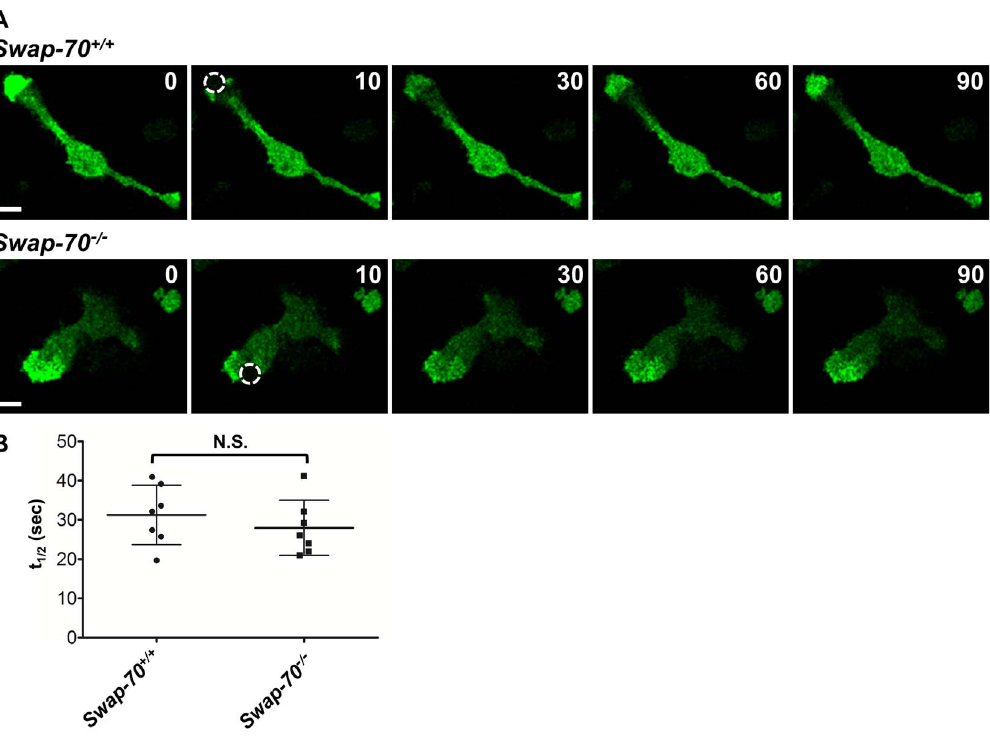
Figure 3. Podosome turnover is not affected by SWAP-70 deficiency in DCs. ( A ) FRAP analysis. Actin-GFP transduced Swap-70 + / + and Swap- 70 –/– DCs were seeded on poly-L-lysine coated glass coverslips and discrete areas (white circles) were photobleached. Representative selected pictures are shown with times in seconds. ( B ) Quantification of fluorescence recovery half-time (t 1/2 ) in seconds from experiments in (A). Mean values of 7 individual photobleached cells per genotype of 2 independent experiments with error bars indicating 6 SD are shown. N.S. denotes not